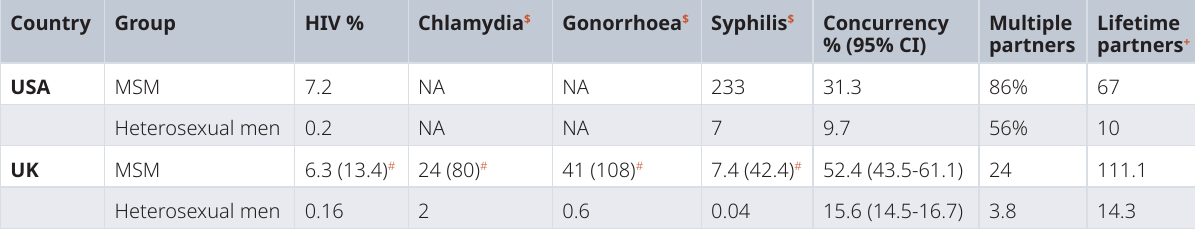
Table 5. Prevalence/incidence of HIV, HSV-2, chlamydia, gonorrhoea, syphilis, concurrency and multiple partnering by men who have sex with men (MSM) versus heterosexual men the United Kingdom and the Unites States. Country Group HIV %